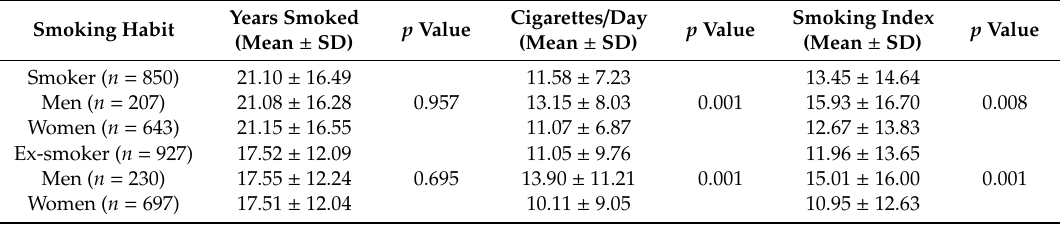
Table 5. Measurement of smoking habit among smokers and